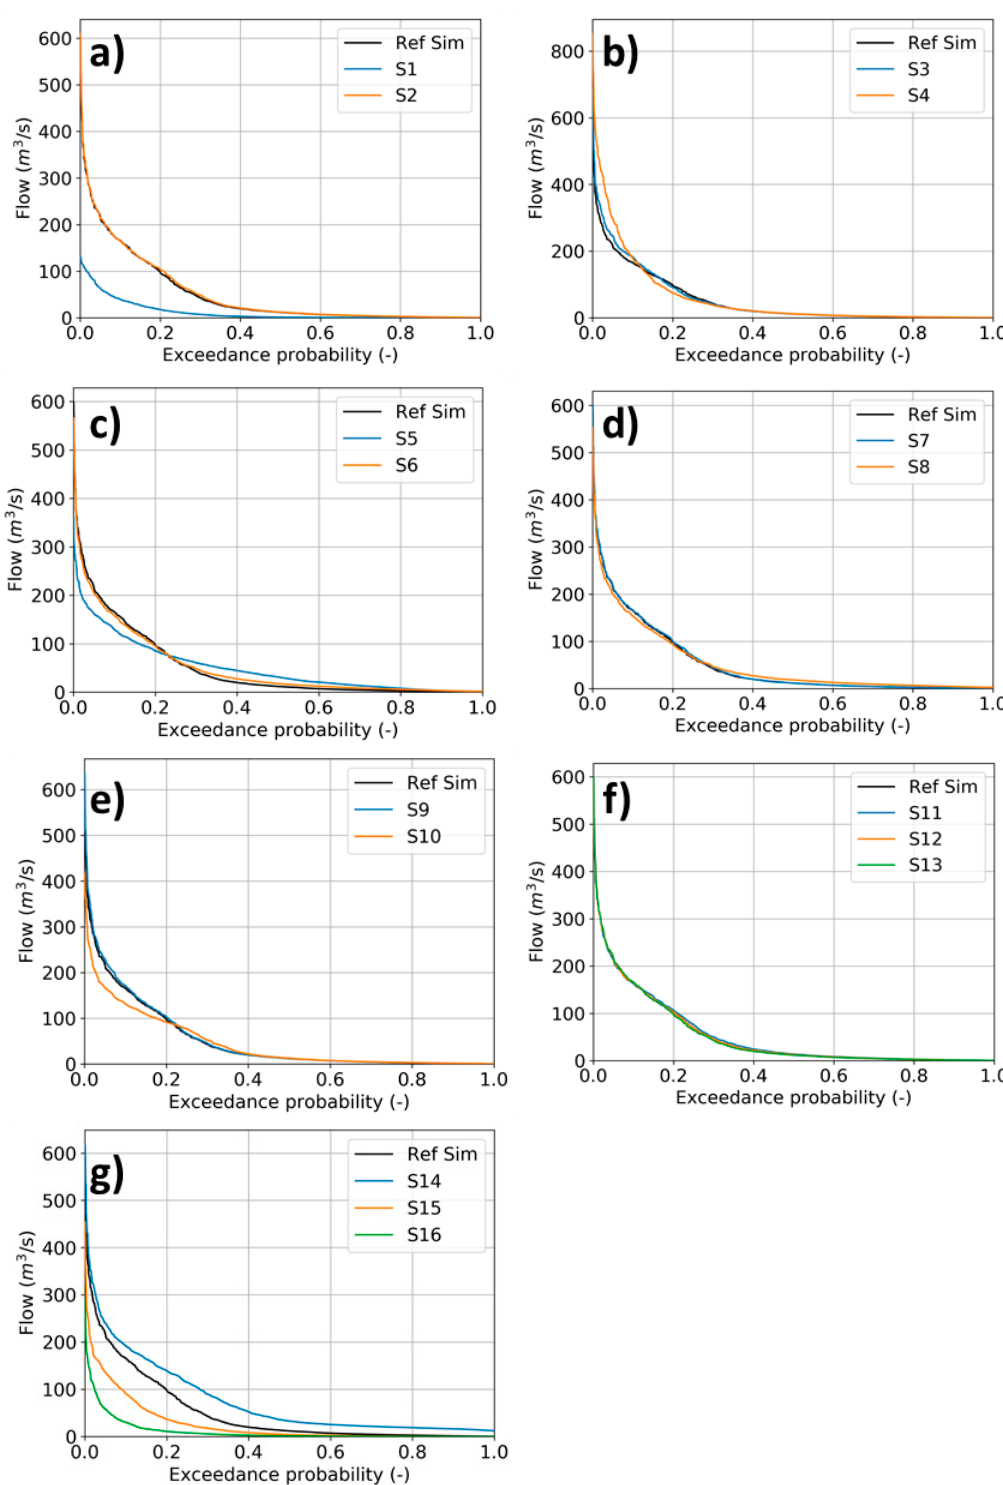
Figure 7. Flow-duration curves for the simulations considered during sensitivity analysis. Impact of: ( a ) grid resolution (S1) and elevation data (S2); ( b ) cross-section widths and heights (S3 and S4); ( c ) vertical and horizontal saturated hydraulic conductivities (S5 and S6); ( d ) vertical soil discretization and soil depth (S7 and S8); ( e ) surface and channel Manning coefficients (S9 and S10); ( f ) infiltration methods (S11, S12, and S13); ( g ) porous media and vegetation processes (S14, S15, and S16) (see Section 2.4 for details).